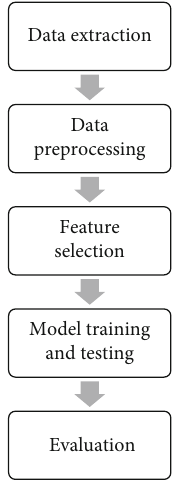
Figure 2: Proposed